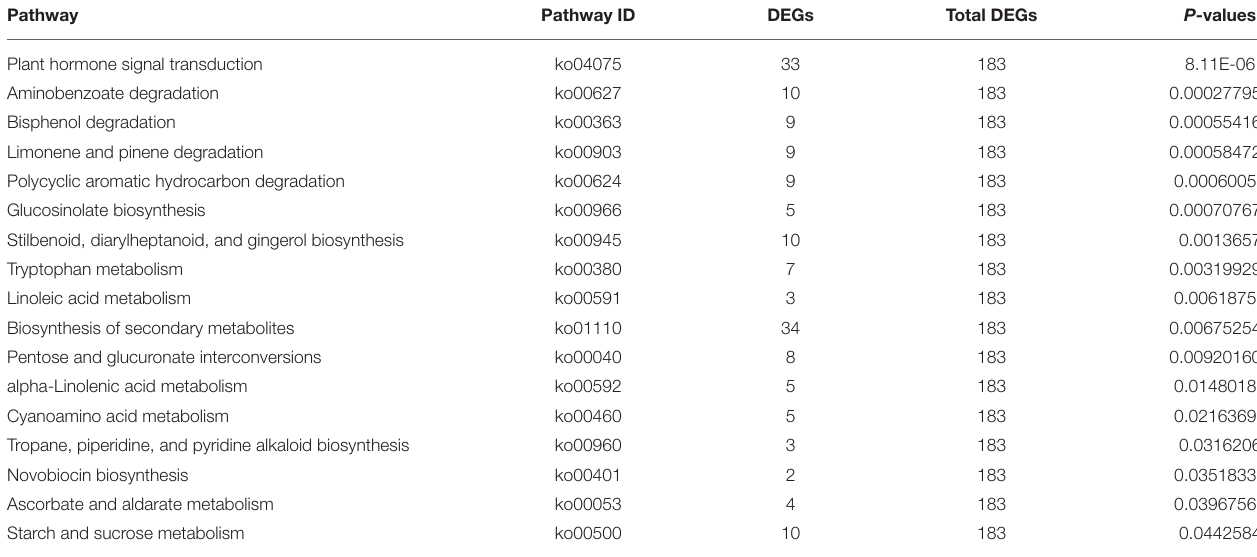
TABLE 5 | Significantly-enriched KEGG pathways of DEGs in drm vs. “FT.” Pathway Pathway ID DEGs Total DEGs P -values